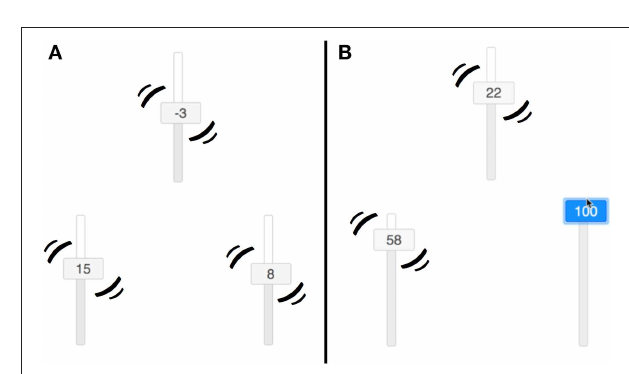
FIGURE 4 | Sliders used by participants. (A) Shows that the sliders all jitter if no interventions are made. (B) Shows that the sliders do not jitter if intervened